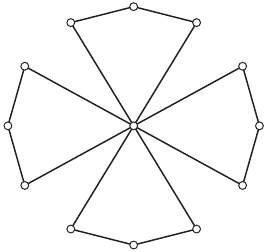
Figure 7. The Dutch graph D 4